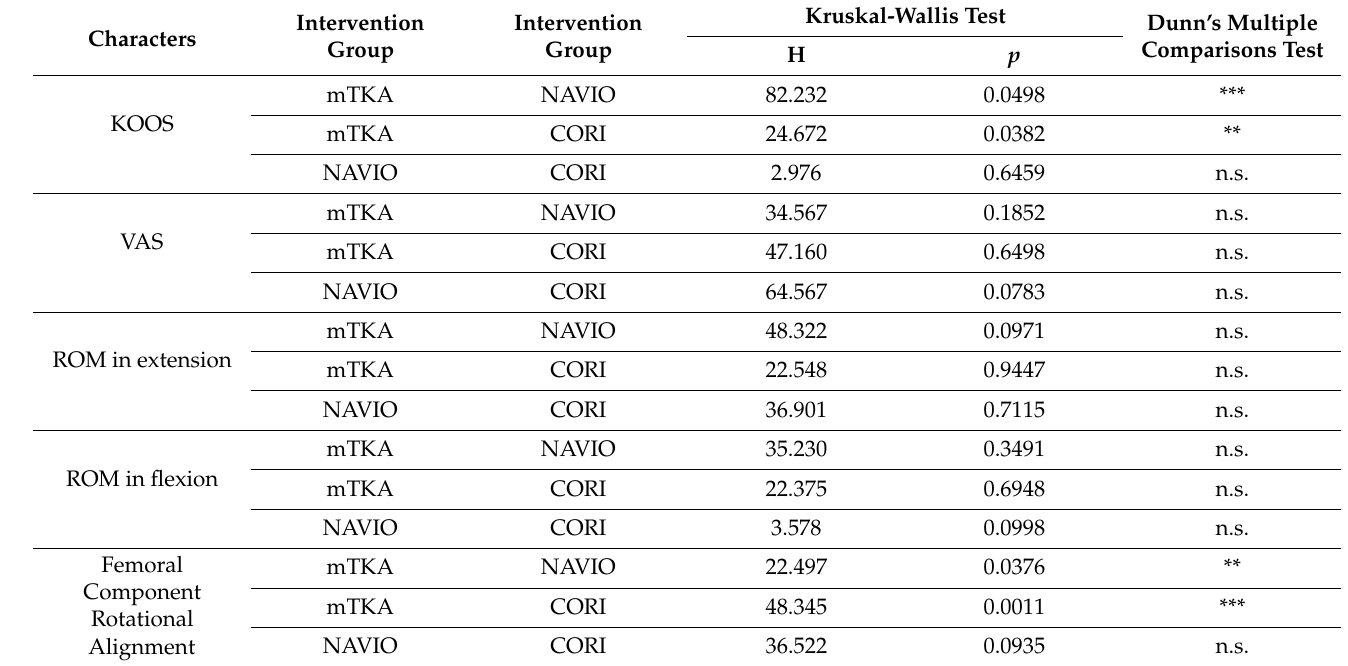
Table 5. Ra-TKA vs. mTKA postoperative outcomes represented as results of Kruskal-Wallis test and the post hoc Dunn’s multiple comparisons test, showing significance of differences in analyzed values between ra-TKA (NAVIO/CORI groups) and the mTKA